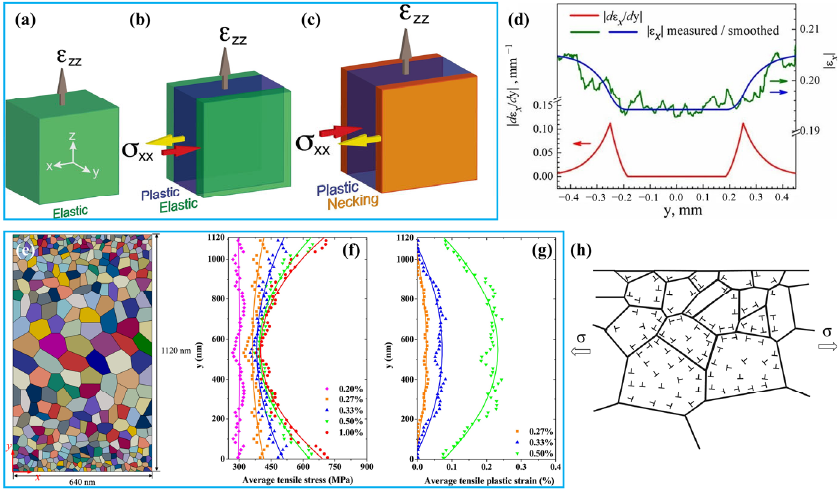
Figure 11. Schematics of the change of stress state during tensile testing of GNG structure [163]. ( a ) Stage I; ( b ) stage II; ( c ) stage III; ( d ) distribution of the lateral strain ( ε x ) and strain gradient (d ε x /dy) in GNG IF steel [144]; ( e ) crystal plasticity finite-element model of GNG Cu [164]; distribution of ( f ) gradient axial stresses and ( g ) gradient axial strains in the cross-section at various applied strains [164]; ( h ) schematic illustration of GNDs in plastically deformed GNG structure ( ⊥ represent GNDs near the GBs) [164].